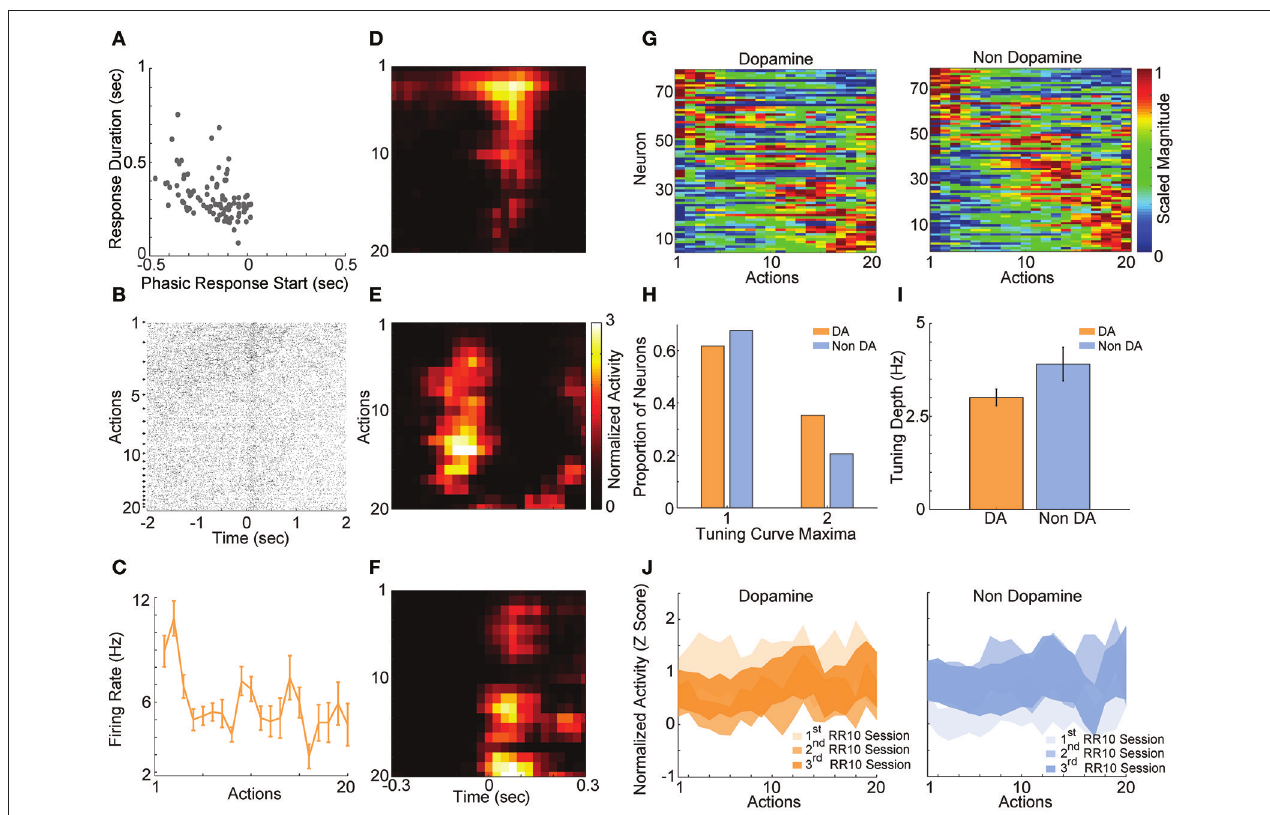
FIGURE 4 | RR10 action evoked VTA responses. (A) Scatter plot depicts response start and duration of action evoked responses in RR10 sessions. Each point represents the data from a single unit. (B) Data from a typical dopaminergic neuron that preferred low action numbers. The raster shows spikes aligned to the time of action execution (time = 0). Each row of the raster represents one action evoked response and rows are arranged by action number. Each arrow on the right represents an action number. For each action number, the earlier occurrences of an Nth numbered action are arranged toward the top. Thus, the first row of the raster represents the first occurrence of an action number 1 (i.e., trial 1), and the second row represents the second occurrence (i.e., trial 2), etc. (C) Depicts the action-evoked responses of the neuron depicted in (B) conditioned on action numbers 1–20. Note that the neuron most strongly prefers actions 1 and 2. (D–F) Neuronal responses aligned to actions for 3 simultaneously recorded neurons. (D) A non-dopaminergic neuron that fires preferentially during lower numbered actions within a trial. Data depicted as the average response evoked by actions 1–20. Data are aligned to the time of action execution (0.025s bins). Only unrewarded actions are depicted. (E,F) A pair of dopaminergic neurons that fire preferentially during upper-middle, and higher numbered actions, respectively. Note that both dopaminergic and non-dopaminergic VTA neurons fire preferentially around distinct subsets of actions. (G) Action number tuning curves during RR10 (0.25s window, centered on action). Each dopamine (left) and non-dopamine (right) neuron’s average, action evoked, normalized, firing rate during execution of actions is plotted by color. Tuning curves are scaled to each curve’s peak (hot colors = tuning curve peak). Neurons are sorted by the location of the peak of the tuning function. Note the diversity of tuning curves to serial actions (H) Proportion of neurons with 1 or 2 tuning curve maxima. (I) Mean ± SEM tuning curve depth. (J) Mean ± SEM neuronal responses as a function of action number in RR10 sessions for dopamine and non-dopamine